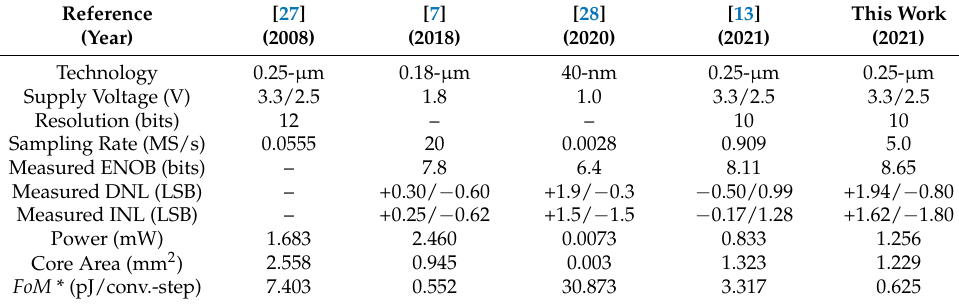
Table 3. Performance summary and comparison with other SAR